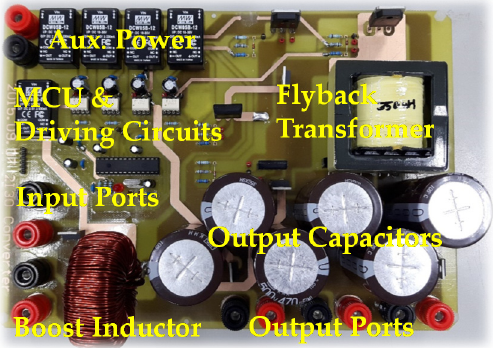
Figure 17. Realized converter prototype.